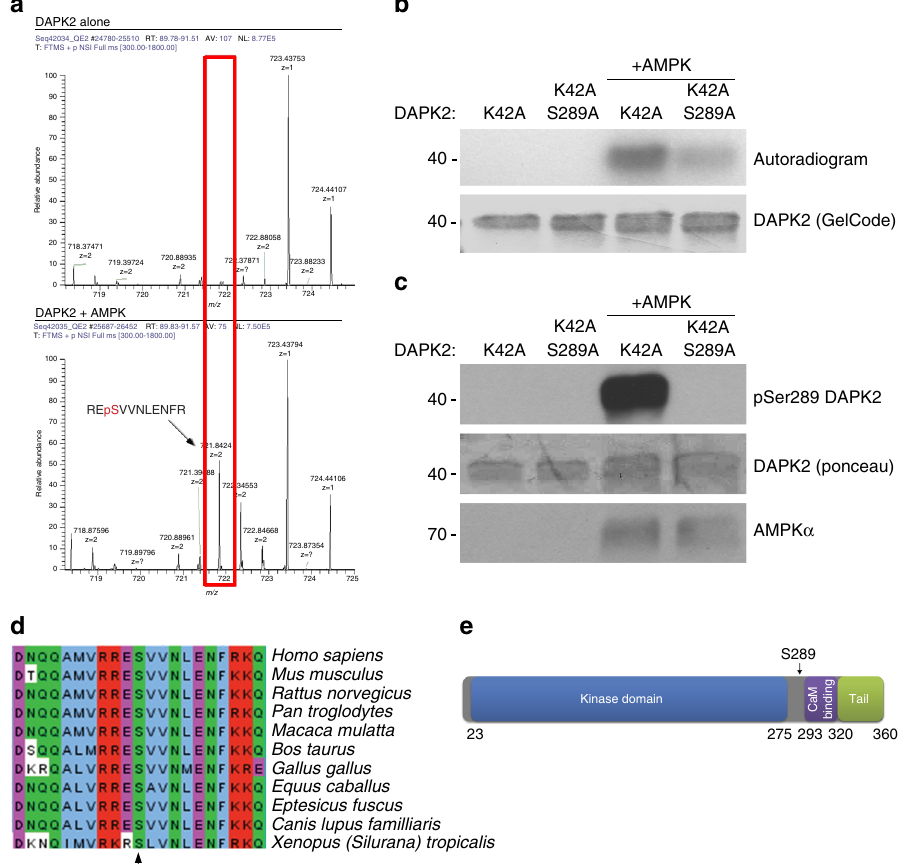
Fig. 1 AMPK phosphorylates DAPK2 on Ser289. a DAPK2-K42A was subjected to an in vitro kinase assay with AMPK and resolved by SDS – PAGE. A sample without AMPK was used as control. The gel was stained with GelCode Blue and the DAPK2 bands in each sample were excised and analyzed by liquid chromatography-mass spectrometry/mass spectrometry (LC – MS/MS) as shown in the graphs. Each peak represents a peptide; the graph height represents the relevant abundance of the peptide in the fraction. b AMPK was incubated with either DAPK2 K42A or DAPK2 K42A S289A in a kinase reaction mixture containing 32 P-labeled ATP. Reactions were resolved by SDS – PAGE and exposed to X-ray fi lm. c AMPK was incubated with either DAPK2 K42A or DAPK2 K42A S289A in a kinase reaction mixture. Reactions were resolved by SDS-PAGE and reacted with an antibody raised against pSer289 DAPK2. d Multiple sequence alignment of different DAPK2 orthologues using ClustalOmega. Ser289 is marked with an arrow. e A scheme showing the different domains of DAPK2. Ser289 is marked with an